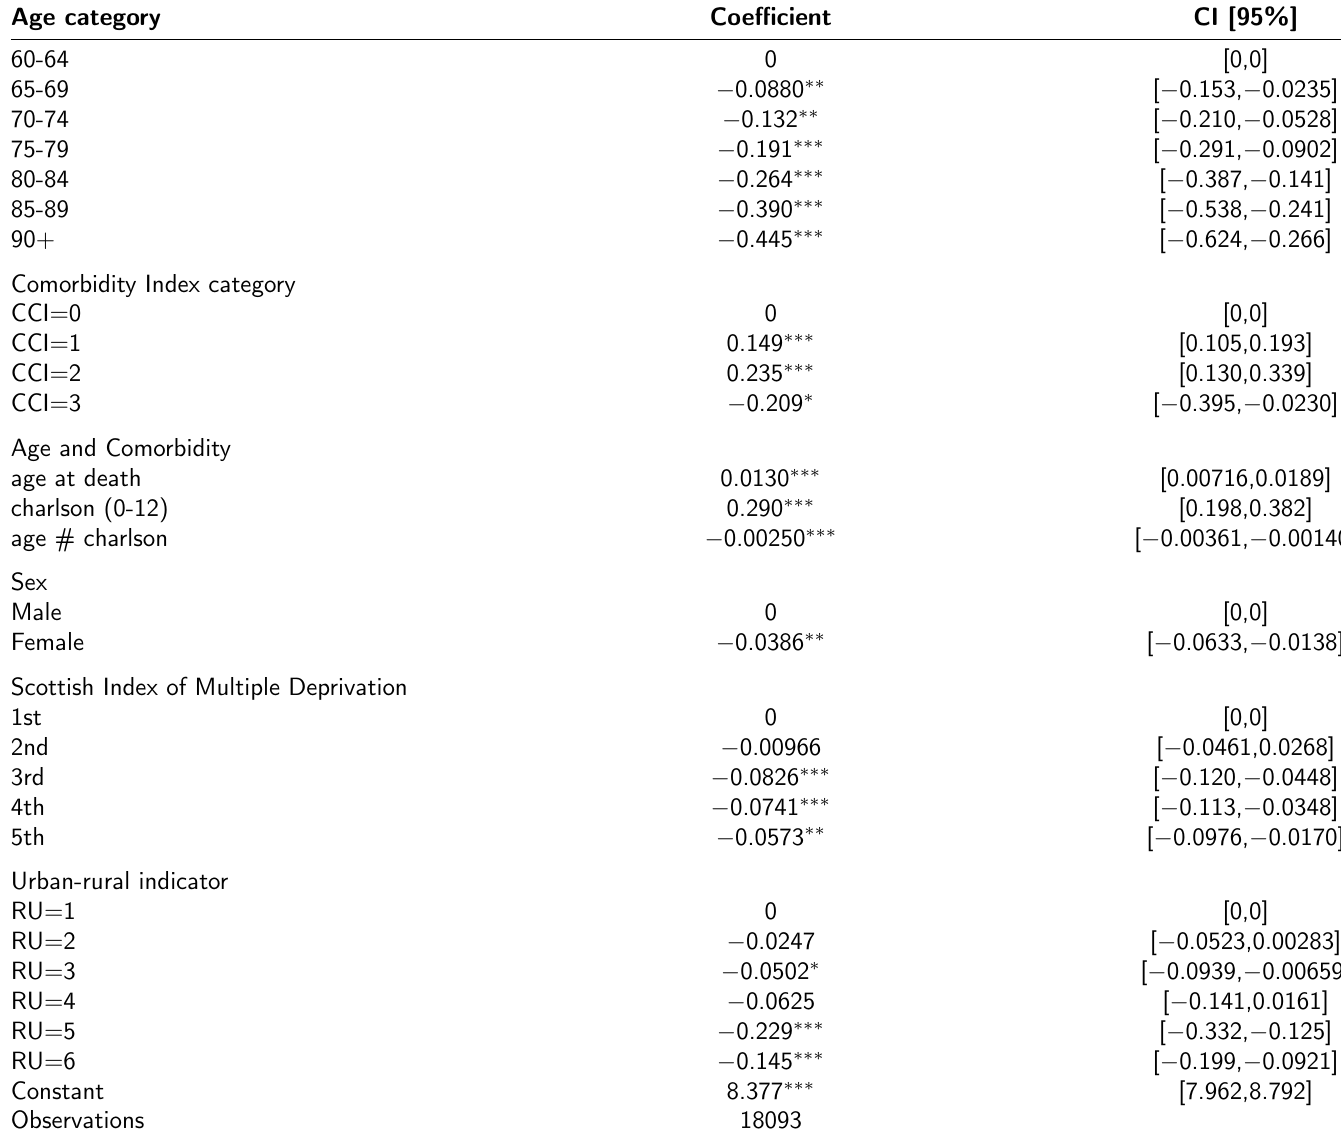
Supplementary Table 9: Multivariate analysis GLM - Cancer NOT main cause of